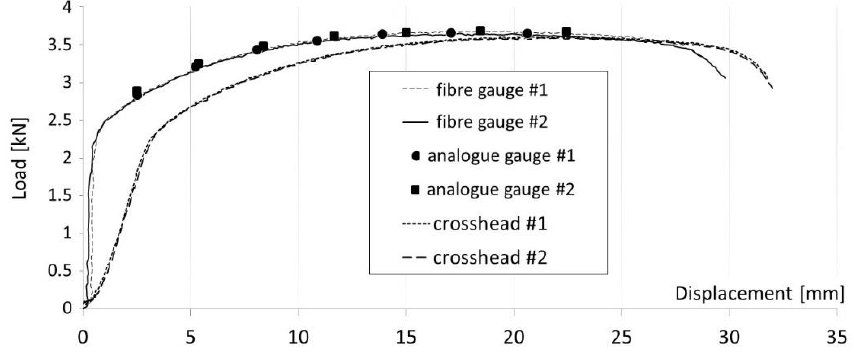
Figure 11. Load – displacement results for three different measurement techniques.